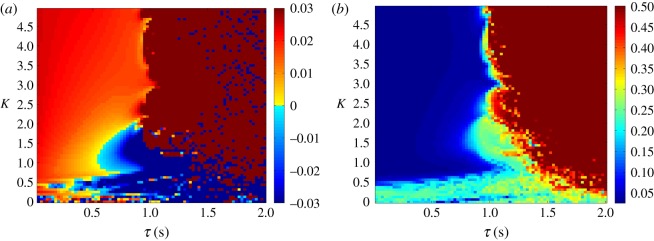
Lag (a) and lag-adjusted RMSE (b) between xtarget and xeffector, plotted as a heat map. τf is set to 0 s, while τ is varied between 0.01 and 2 s. The lag remains close to 0 s within a near-rectangular region bounded by K>1 and τf<1 s, while at higher delays tracking no longer occurs and lag cannot be accurately measured. For this reason, the error is saturated at 0.5.